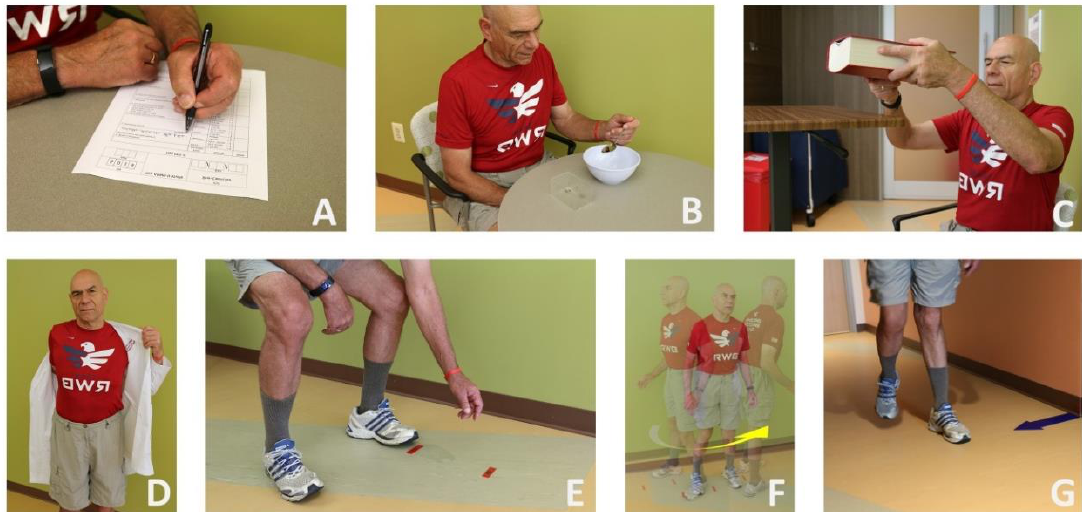
Figure 1. The 7-Item Physical Performance Test. The Physical Performance Test (PPT-7) is a performance-based functional assessment battery for older adults. The PPT-7 tasks include: ( A ) writing a sentence, ( B ) simulated eating, ( C ) lifting a book (approx. 3.2 kg) and placing it on a